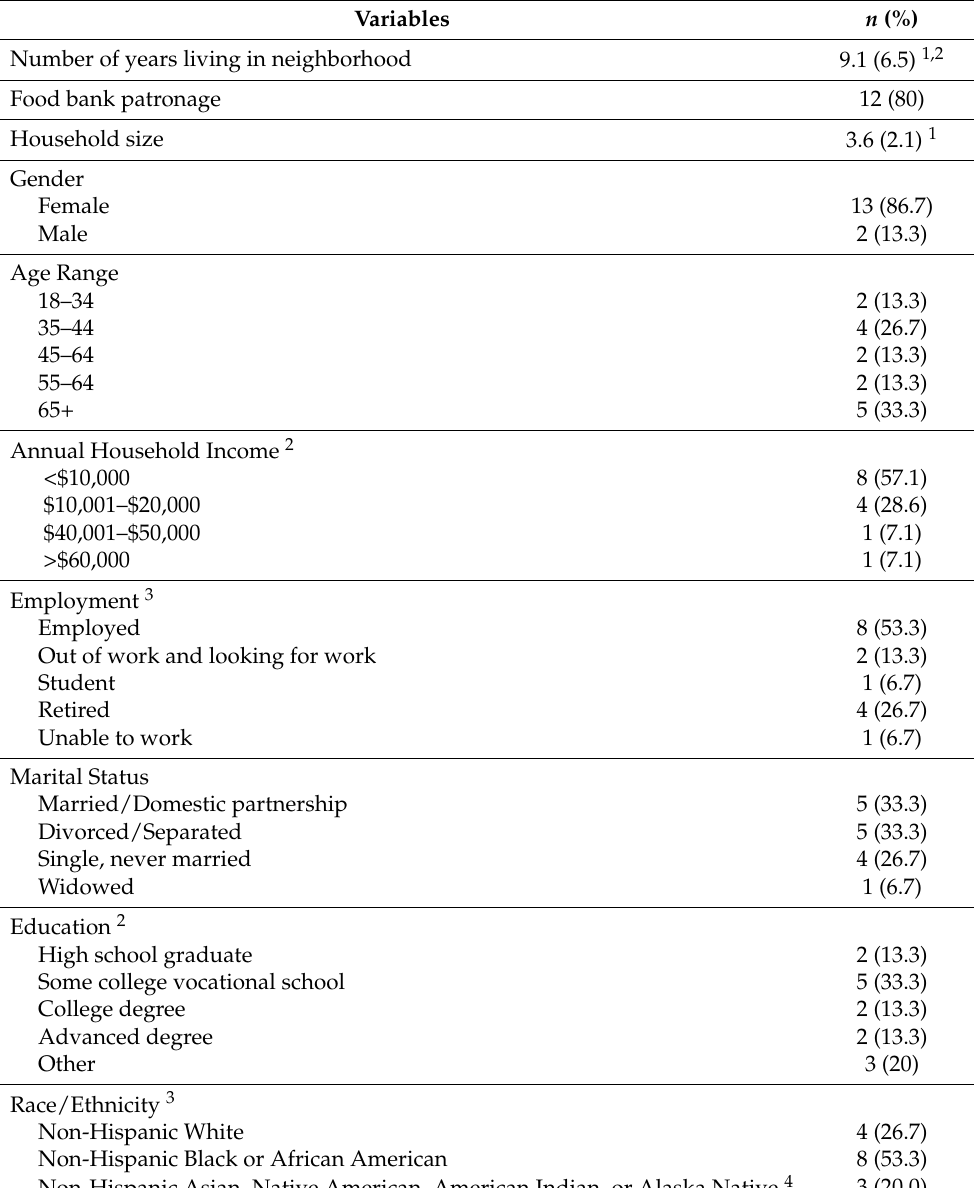
Table 2. Demographic characteristics of participants (N =